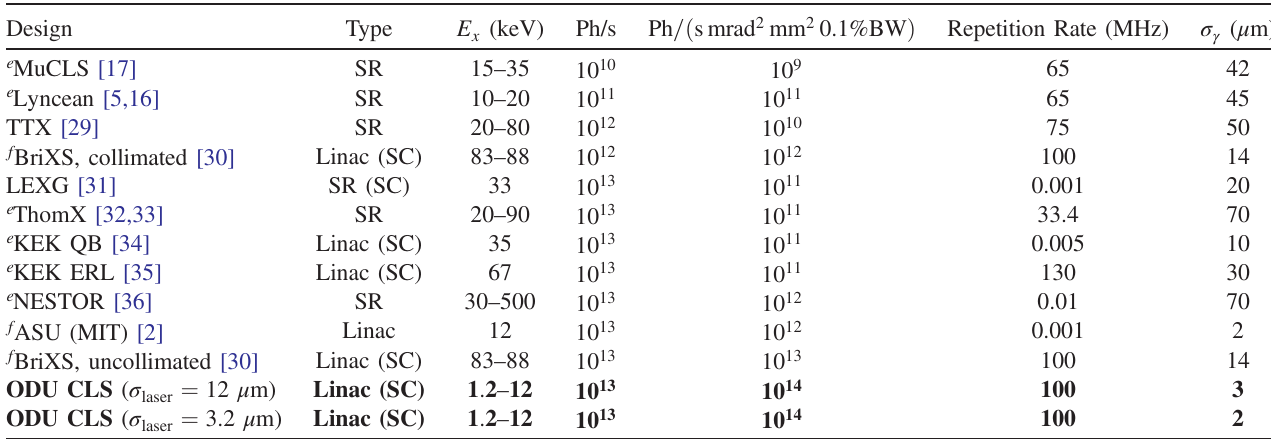
TABLE IV. Comparison of x-ray beam parameters for different ICLS compact designs. e indicates existing designs, f indicates funded designs; (SC) indicates superconducting cavities. Versions of this table and some information within were published previously by Jacquet [6] and Jacquet and Suortti [28]. The bolded lines are the anticipated x-ray beam parameters for the concept presented in this ¼ 3 . 2 μ m) and 12 micron ( σ ¼ 12 μ m) spot size. paper using a scattering laser with a 3.2 micron ( σ laser laser